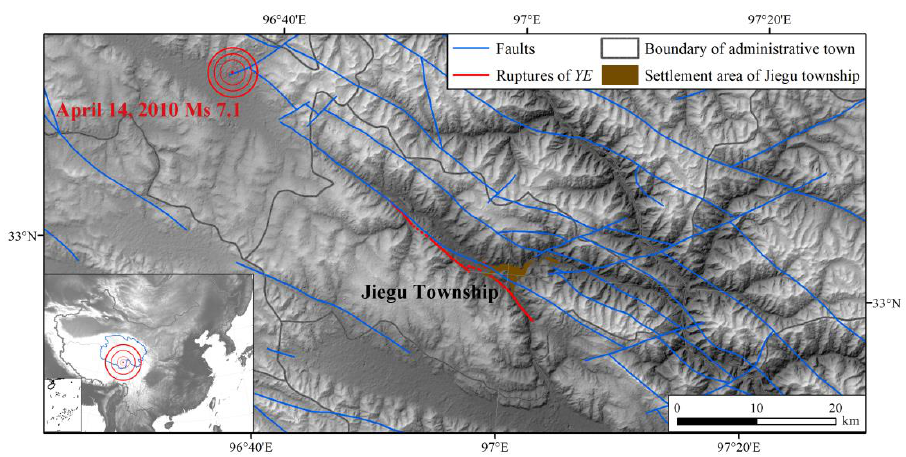
Fig. 1. Location of Jiegu township. The red concentric circles indicate the epicentre of YE. It is shown that Jiegu township is located on the Ganzi-Yushu fault zone and adjacent to the YE epicentre. The ruptures of YE mapped in field survey are presented using red lines.